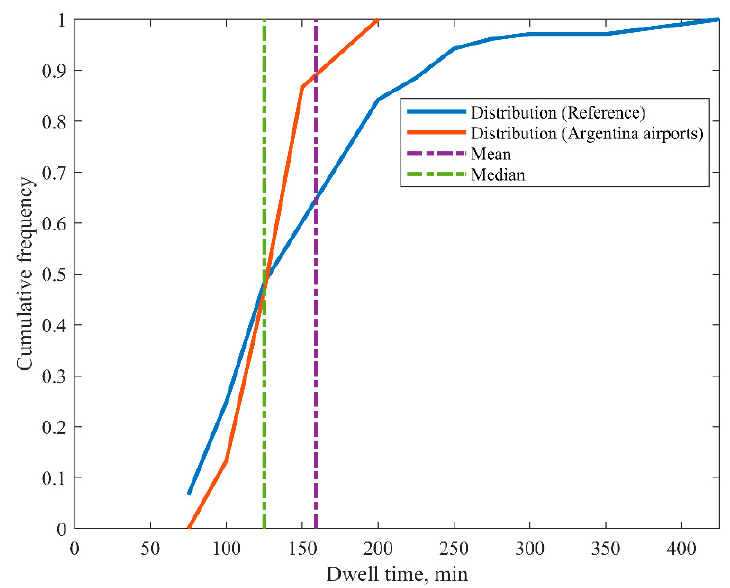
Figure A7. Characterization of dwell time process.